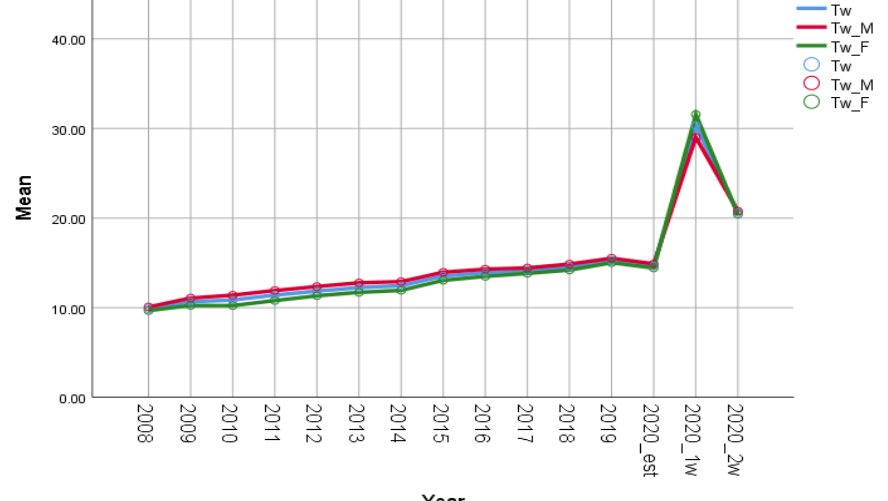
Figure 5. The percentage of teleworkers for 2008–2020.